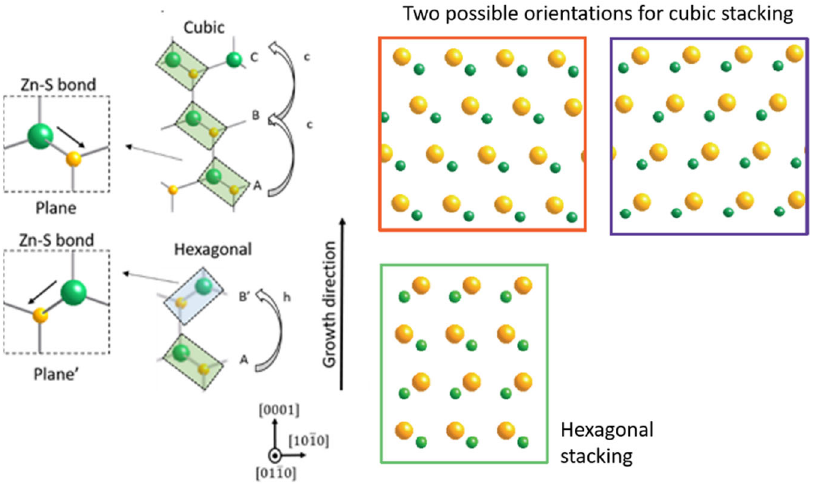
Figure 10. Notation of the planes with respect to the direction of the Zn-S bond not parallel to the growth direction: the stacking gives either hexagonal h or cubic c planes.